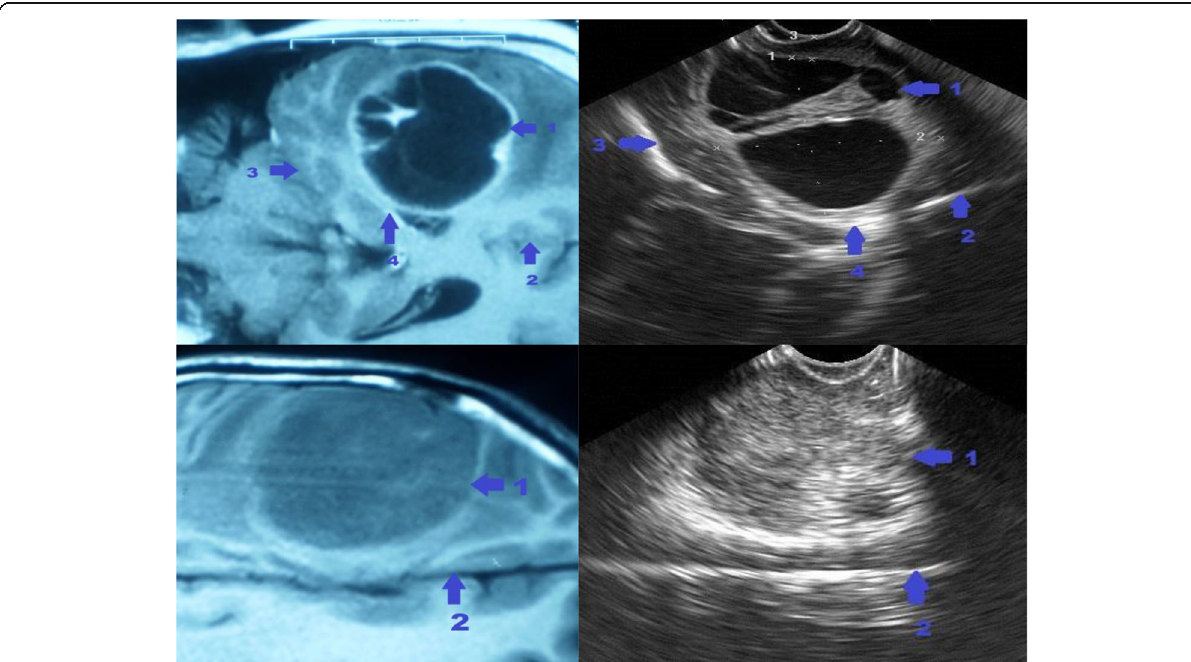
Fig. 3 Brain dura and choroid plexus; arrow1 brain mass lesion, arrow2 homogenous hyper-echogenic falx cerebrai, arrow3 homogenous hyper- echogenic tentorium cerebelli, and arrow4 homogenous hyper-echogenic choroid